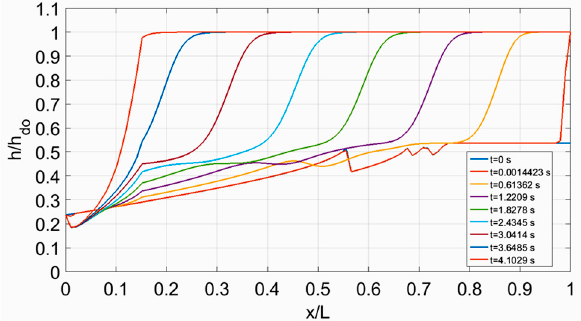
Figure 9. Evolution of the convergence criteria: ( a ) for test case 2 with Dissipative scheme with Boussinesq terms; ( b ) for test case 5 with MacCormack scheme without Boussinesq terms.